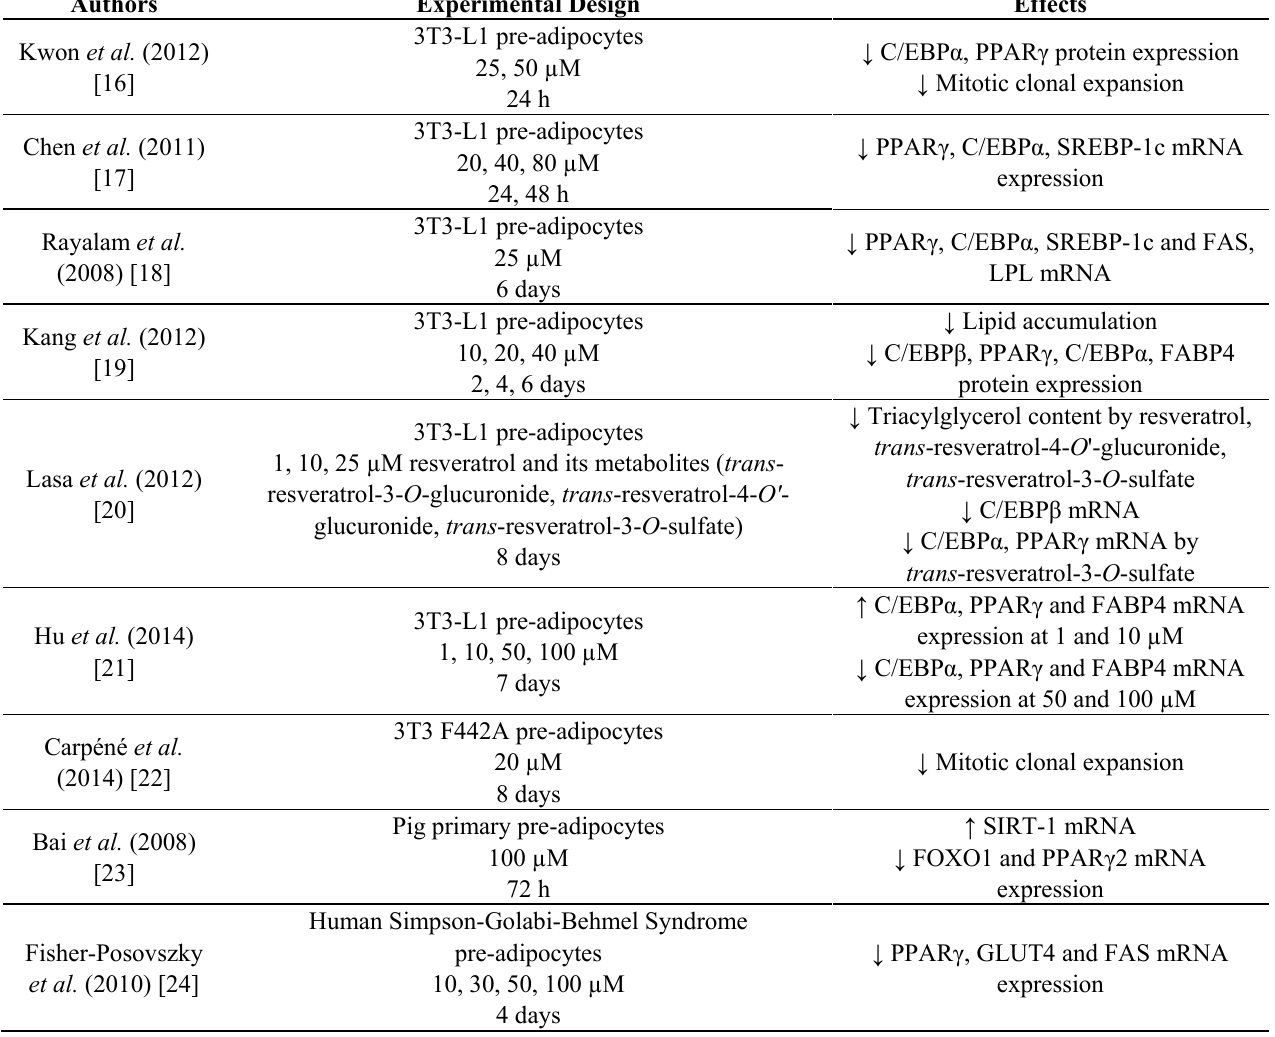
Table 1. Effects of resveratrol on adipogenesis in in vitro